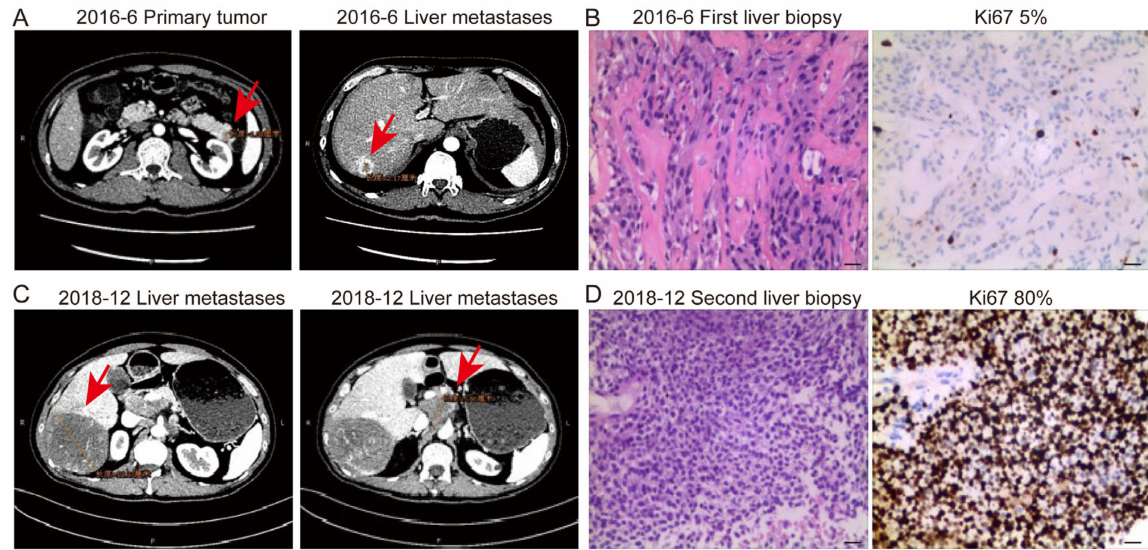
Figure 4. Contrast-enhanced computed tomography showed primary tumor and liver metastases (red arrows) at initial diagnosis and progression. ( A , C ). Hematoxylin and eosin staining and im- munohistochemistry staining of Ki67 of each lesion. Scale bar indicates 20 µ m. The Ki67 indexes of the first and second liver biopsies were 5% ( B ) and 80% ( D ),